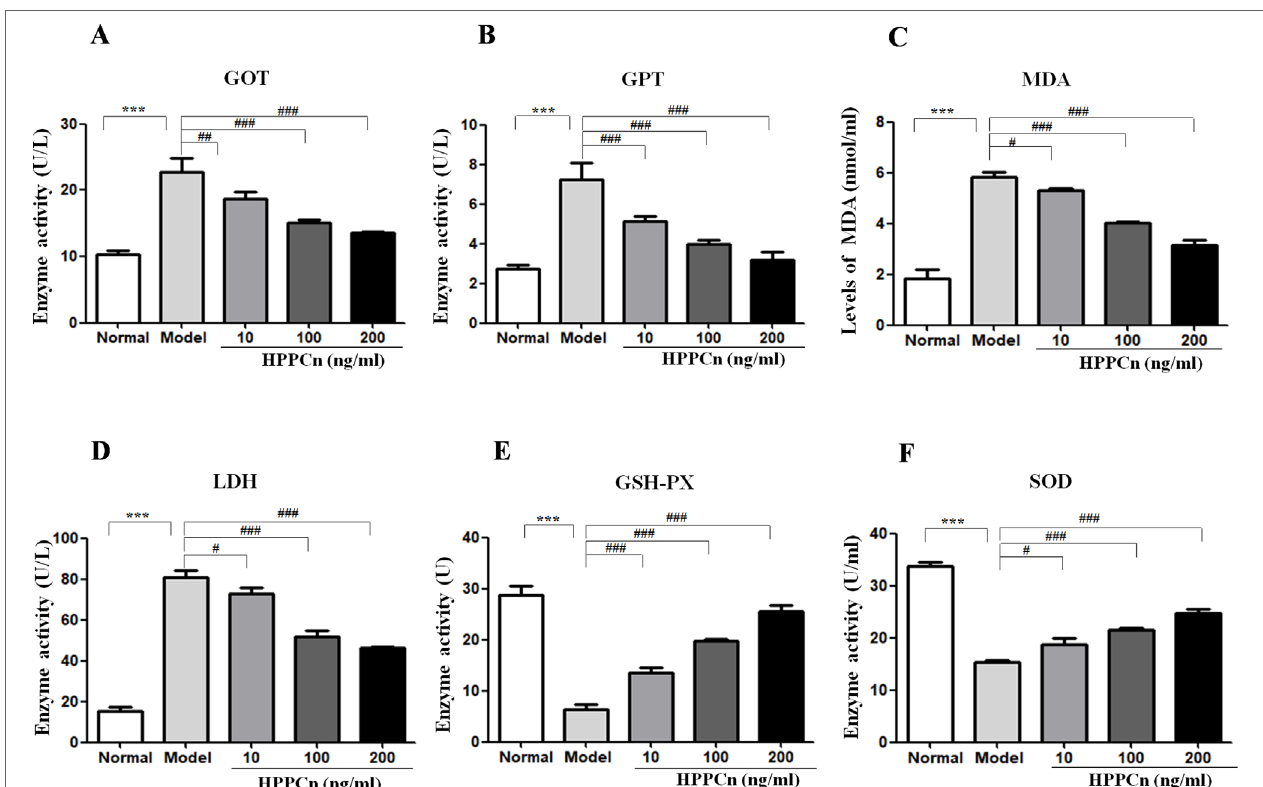
FIGURE 4 | rhHPPCn reduced CCl 4 -induced cytotoxicity in SMMC7721 cells. The levels of hepatocyte injury indicators, including GOT, GPT, MDA, LDH, GSH-PX, and SOD in the cell lysate were evaluated by ELISAs in cells treated with different concentrations of rhHPPCn for 24 h after 10 mmol/L CCl 4 -induced cell injury. (A–D) GOT, GPT, MDA, and LDH. (E and F) GSH-PX, SOD. rhHPPCn treatment significantly reversed the increased serum level of GOT, GPT, MDA, and LDH and significantly reversed the decreased serum level of GSH-PX and SOD in a dose-dependent manner after acute cell injury. *** P < 0.001 vs. Control; # P < 0.05, ## P < 0.01, ### P < 0.001 vs.